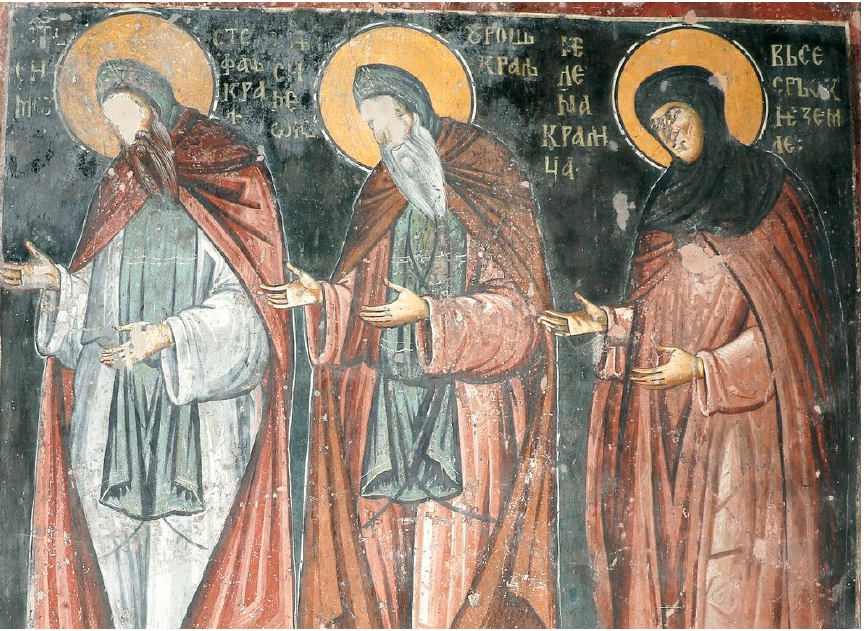
Figure 8. Queen Helen as a nun, procession of Nemanide monks, 1295–1297, Church of St. Achillius in Arilje, south wall of the nave. Photo Nenad Vuki ć evi ć , Blago Fund, Inc. 7. Icons